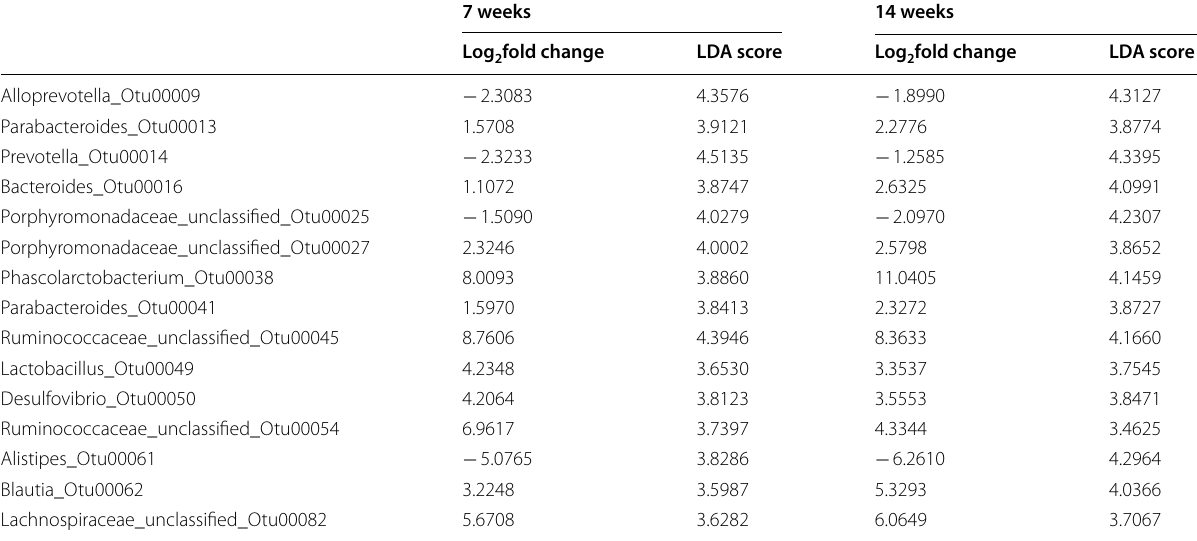
Table 3 Common OTUs altered significantly in ChowCaf compared with ChowChow offspring at both 7 and 14